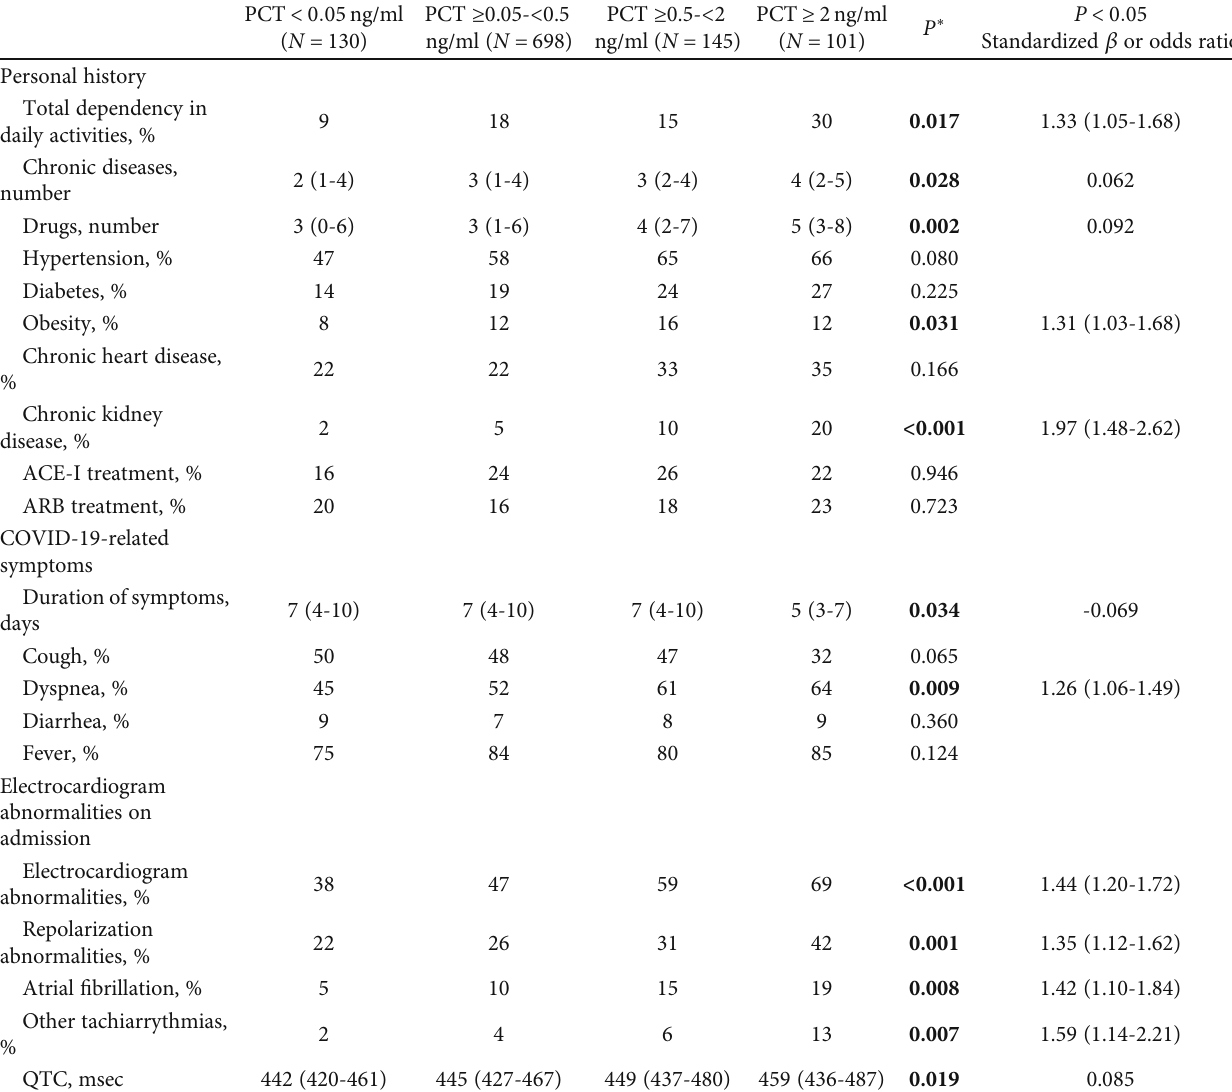
Table 2: Anamnestic and electrocardiographic characteristics the 1074 study participants, strati fi ed according to procalcitonin levels on